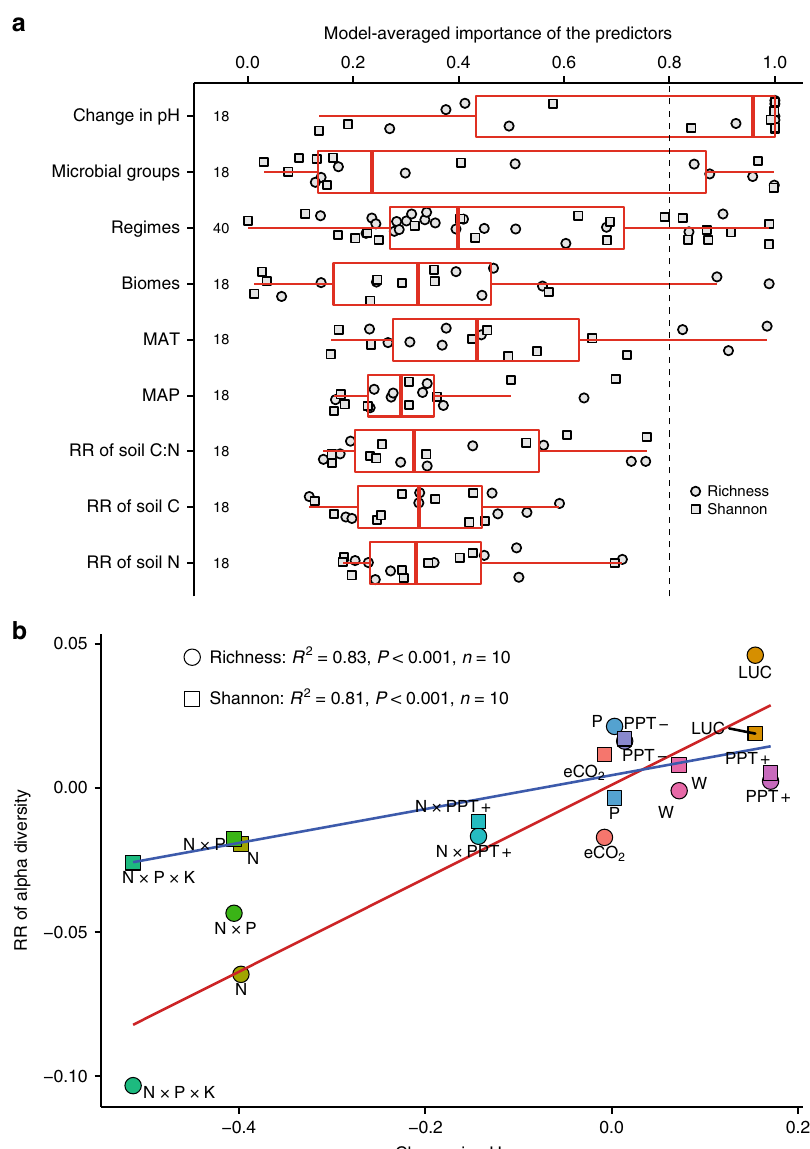
Fig. 3 Contributors to response of microbial alpha diversity to global change factors. a Model-averaged importance of the predictors for response ratios (RRs) of richness and Shannon index based on the sum of Akaike weights derived from the model selection using AIC (Akaike ’ s information criteria corrected for small samples). A cutoff of 0.8 (the dashed line) is set to differentiate between important and nonessential predictors. Boxplots show whiskers (denote the lowest and highest values), quartiles, and median of model-averaged importance for different predictors (see Supplementary Fig. 4). b Linear relationships between changes in soil pH and RRs of richness ( y = 0.16 x + 0.001) and Shannon index ( y = 0.06 x + 0.005). W warming, eCO 2 carbon-dioxide enrichment, PPT − decreased precipitation, PPT + increased precipitation, P phosphorous addition, N nitrogen addition, LUC land-use change, W × eCO 2 warming plus carbon-dioxide enrichment, N × PPT + nitrogen addition plus increased precipitation, N × P nitrogen plus phosphorous addition, N × P × K nitrogen plus phosphorous plus potassium addition. Source data are provided as a Source Data fi